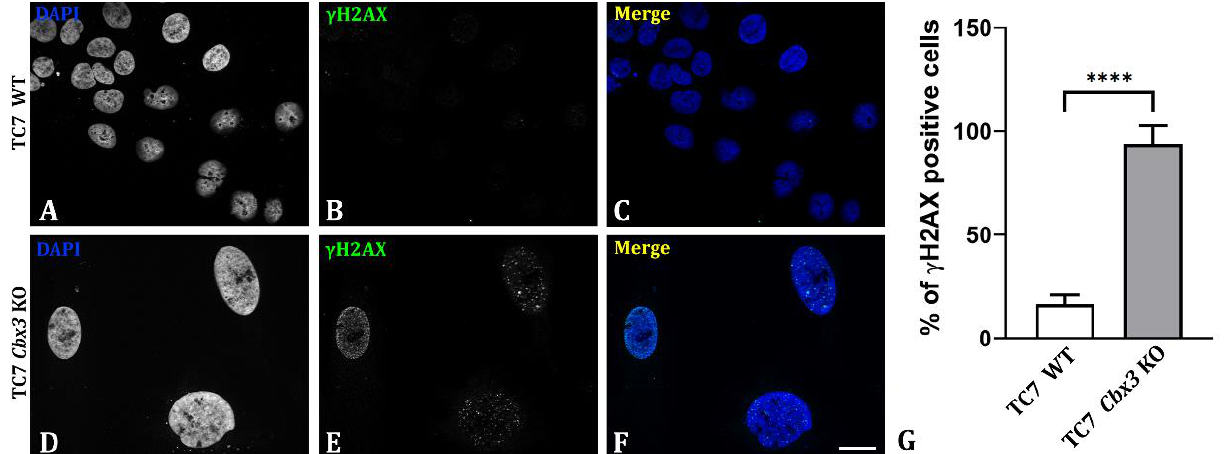
Figure 5 . Analysis of the induction of DNA damage foci upon loss of HP1γ in TC7 cells. ( A – F ) Immunofluorescence study for detecting DNA damage foci, defined by γH2AX detection in TC7 WT ( A – C ) and TC7 Cbx3 KO cells ( D – F ). ( G ) Quantitative analysis of γH2AX upregulation after loss of HP1γ in TC7 enterocytic cells. n = 5 clones (generated by 1 sgRNA) per condition, 2 plates per clone (in WT, different plates were analyzed together). Values are mean ± SD. **** p < 0.0001 ( t -test and non - parametric, two - tailed p value). Scale bar: 25 µm.